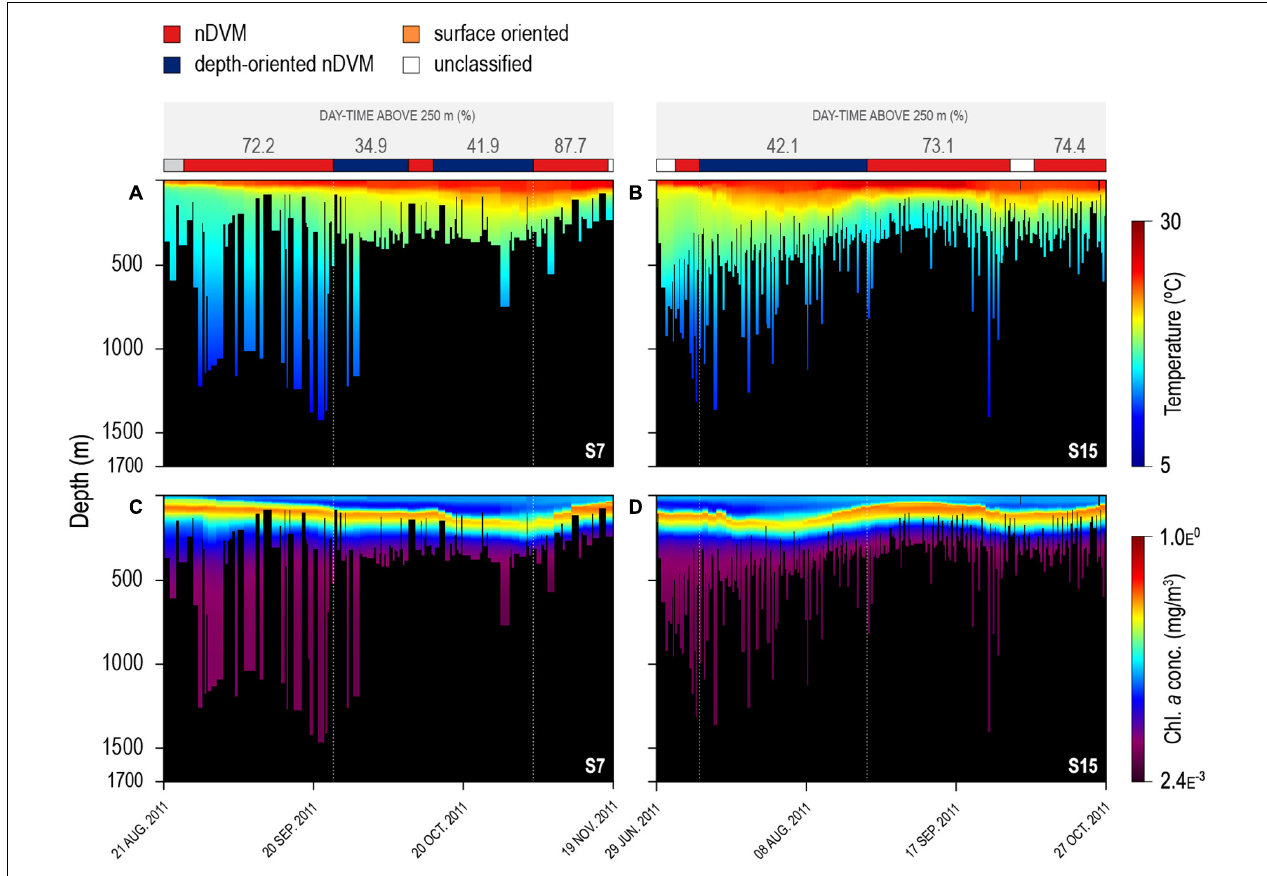
FIGURE 3 | Maximum daily dive depths for two individual blue sharks, shark #7 on the left (A,C) and #15 on the right (B,D) . Dive series are overlaid on water temperature (A,B) and chlorophyll a concentration (C,D) . Coloured bar above represent the identified diel behaviour.